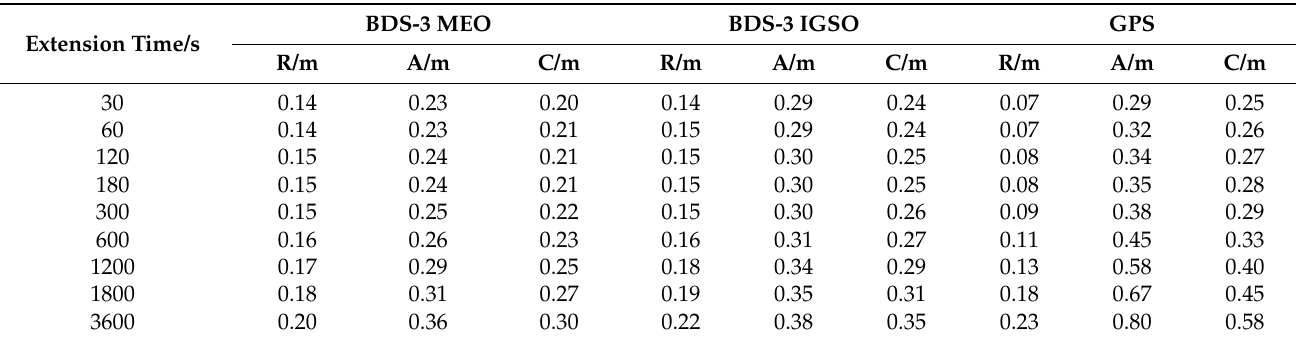
Table 1. Mean RMSE of the PPP-B2b orbit products recovered with extension corrections using the GBM orbit products as a reference during DOY 192–198 in 2022.